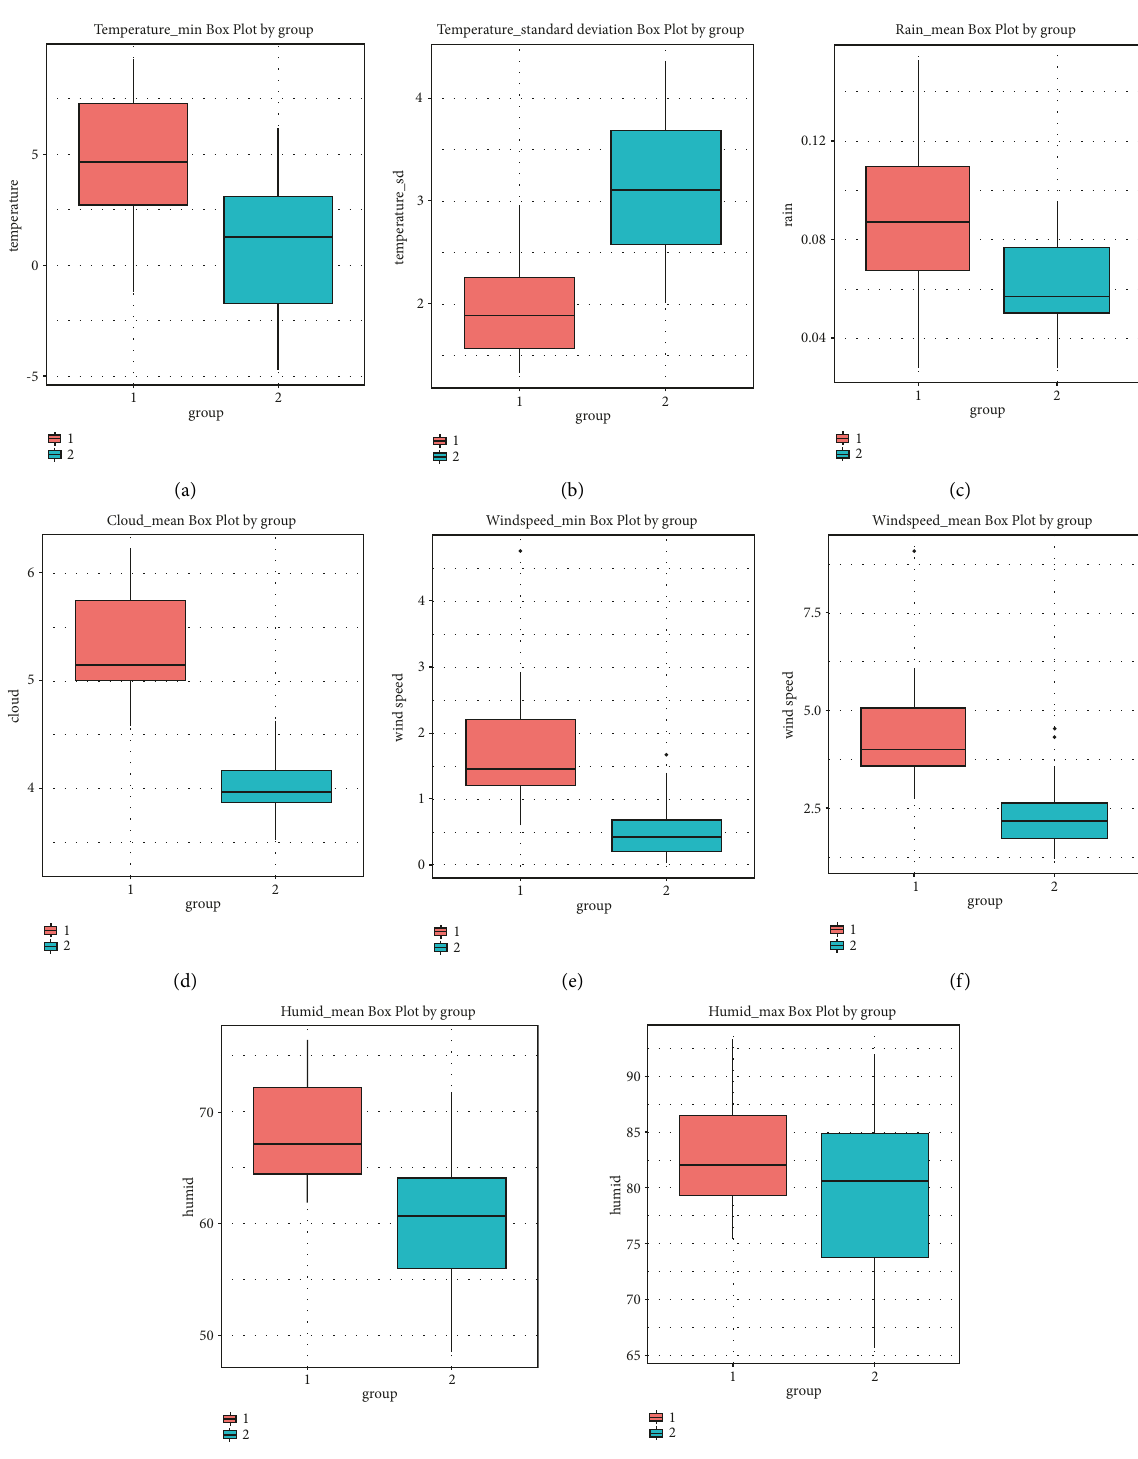
Figure 4: Box plot by group: (a) minimum temperature, (b) standard deviation in temperature, (c) average precipitation, (d) average cloudiness, (e) minimum wind speed, (f) average wind speed, (g) average humidity, and (h) maximum